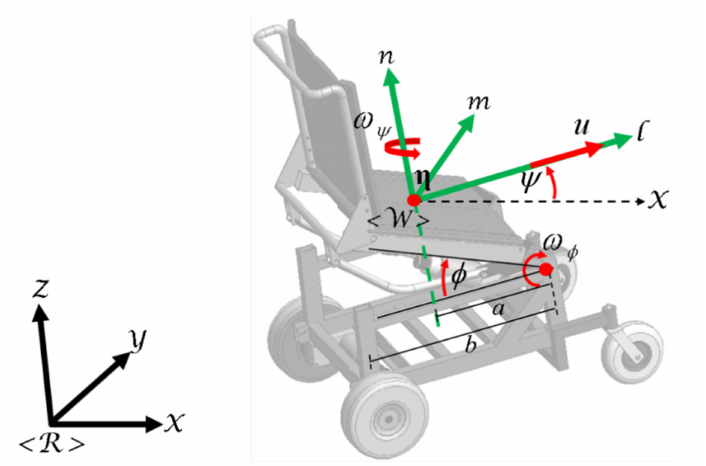
Figure 1. Robotic standing wheelchair with displaced point of interest η ( η x , η y , η z